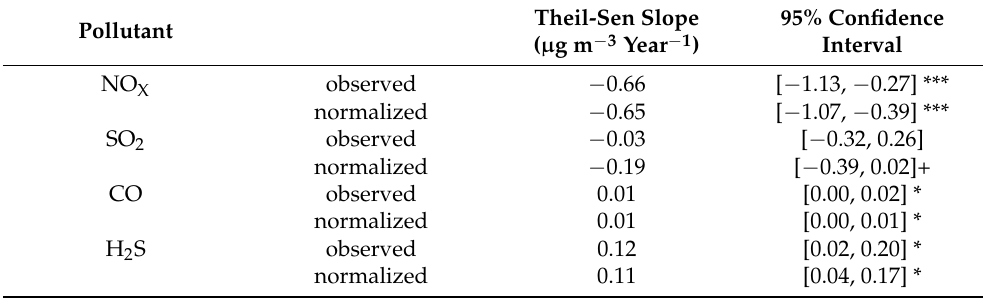
Table 4. Theil-Sen slope and 95% confidence intervals of the observed and meteorologically nor- malized pollutants concentrations. The symbols shown next to the square bracket relate to how statistically significant the trend estimate is: p < 0.001 = ***, p < 0.05 = * and p < 0.1 = +.